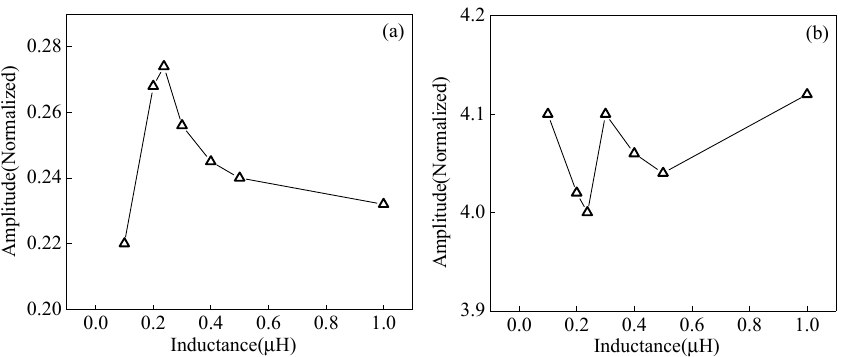
Figure 23. Influence of impedance matching inductance on the ( a ) amplitude ( b ) width of the main lobe of the pulse compressed signal in a carbon steel specimen.